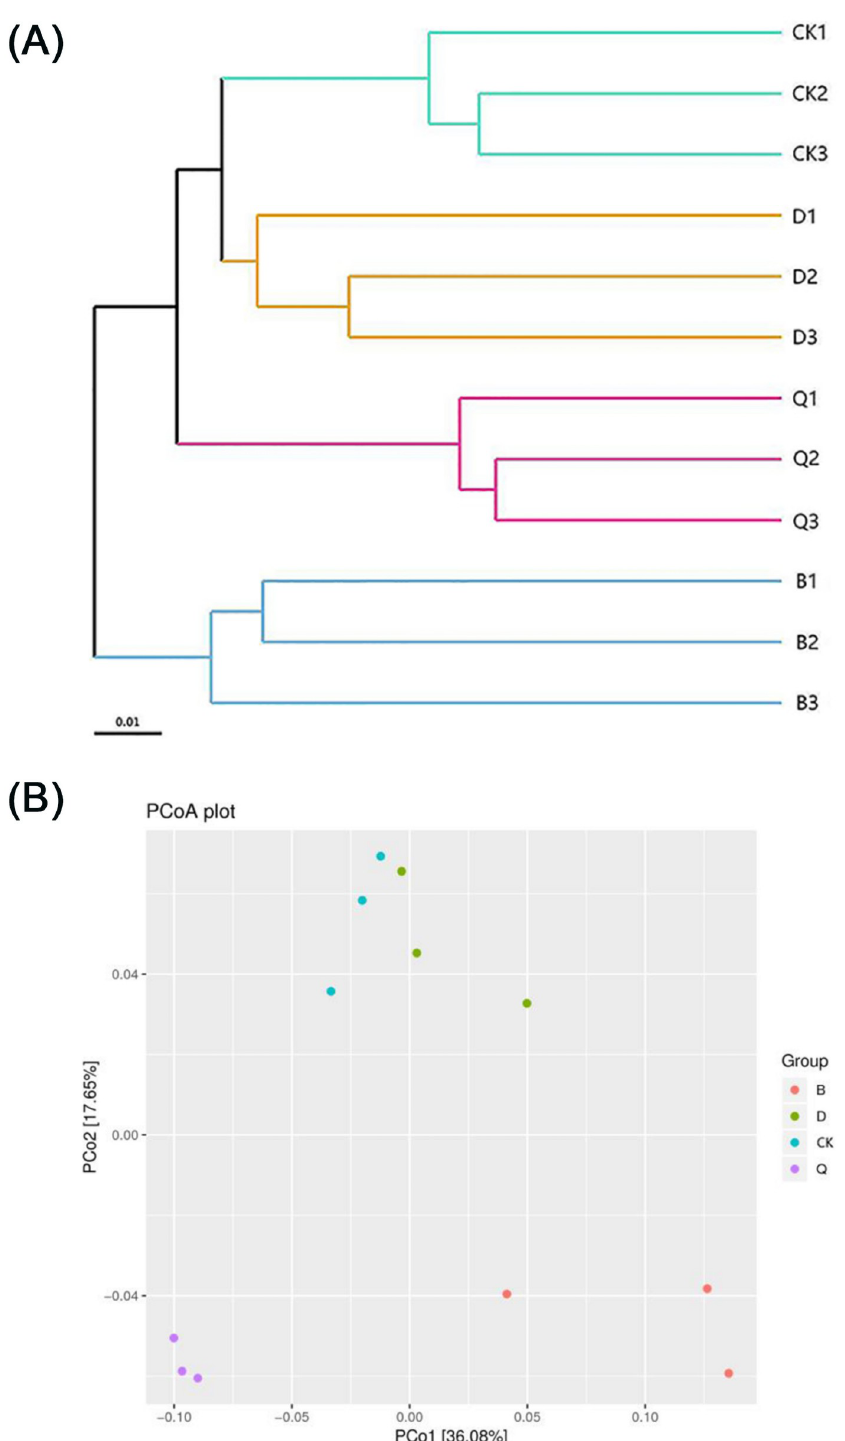
Fig 1. Hierarchical clustering (A) and principal coordinate analysis (B) of the bacterial communities in the continuous tomato cropping substrates based on different cropping systems. CK: Continuous tomato cropping; B: Cabbage/tomato rotation; D: Kidney bean/tomato rotation; Q: Celery/tomato rotation.